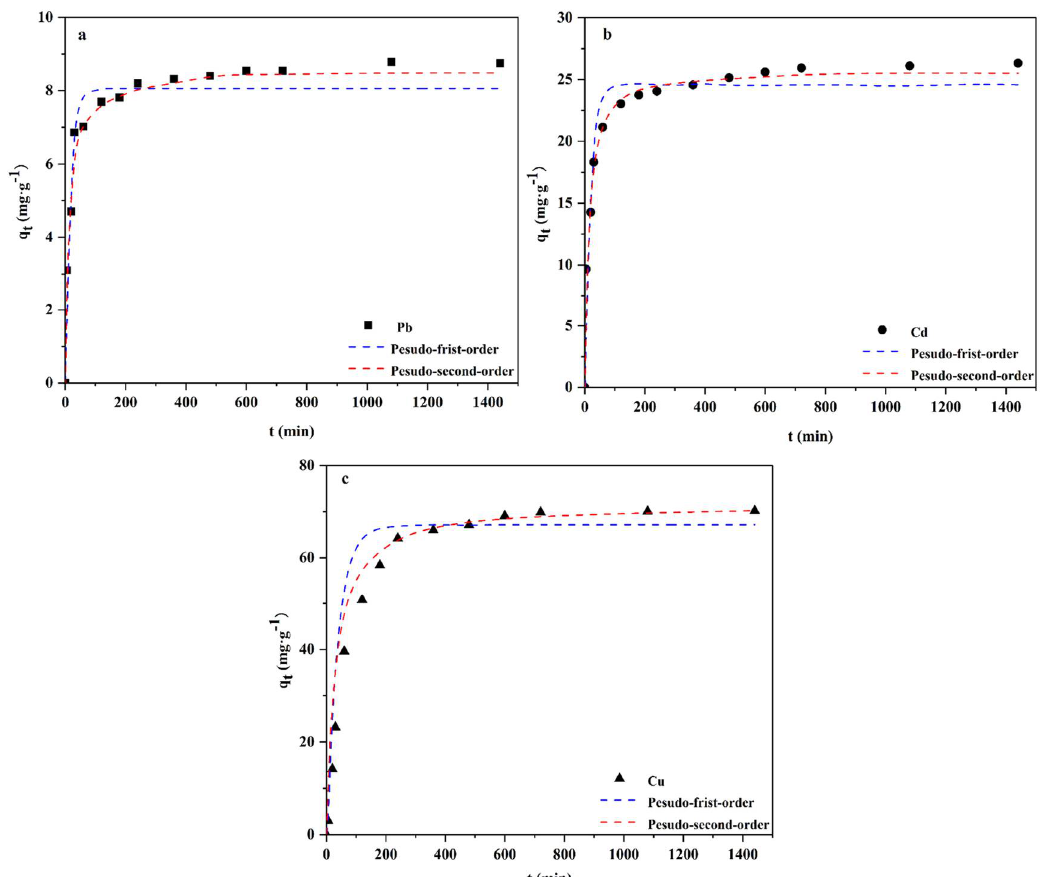
Figure 2. Kinetics of Pb ( a ), Cd ( b ), and Cu ( c ) after GBC adsorption.